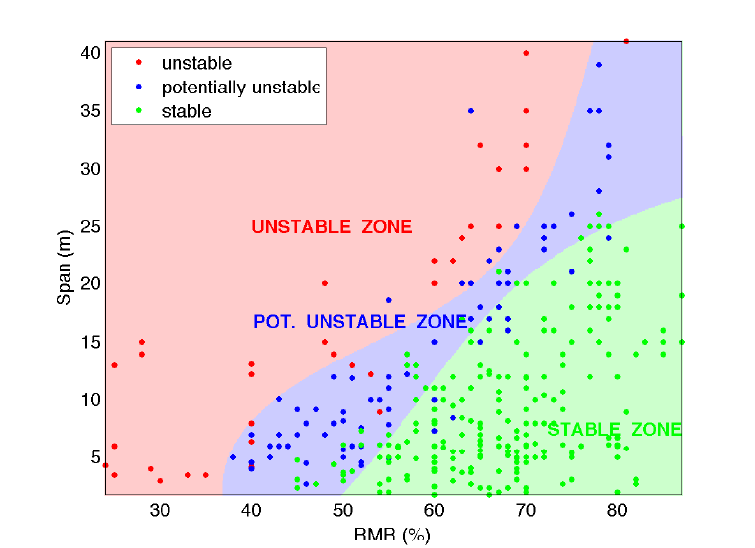
Figure 5. Critical span graph: ELM classification into three